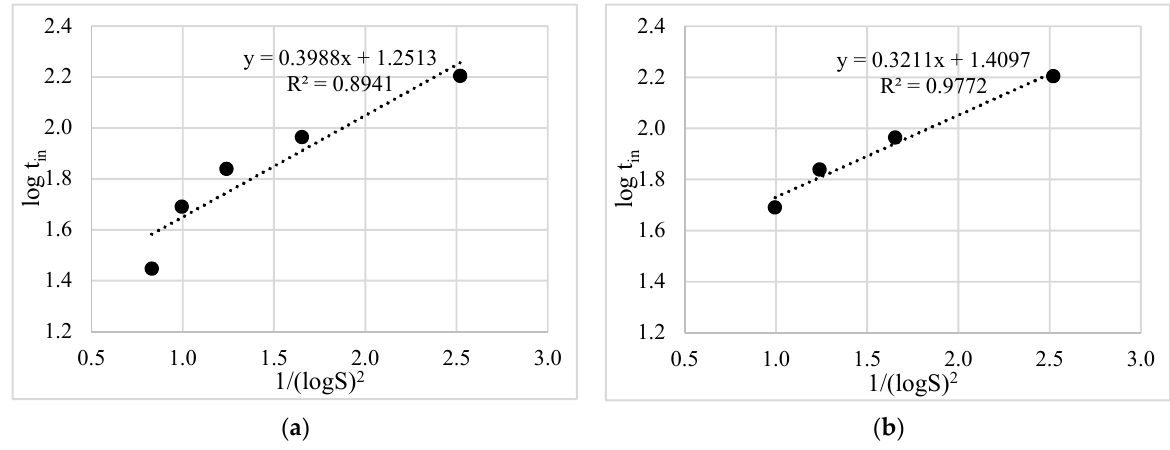
Figure 11. Induction time versus supersaturation ( a ) with all investigated values ( b ) without the smallest value. After plotting log ( t in ) vs. 1/( logS ) 2 for various concentrations and determining the fitting curve, one can also read the sought values of the constants A and B . In this way one can determine the induction time for various concentrations at a given